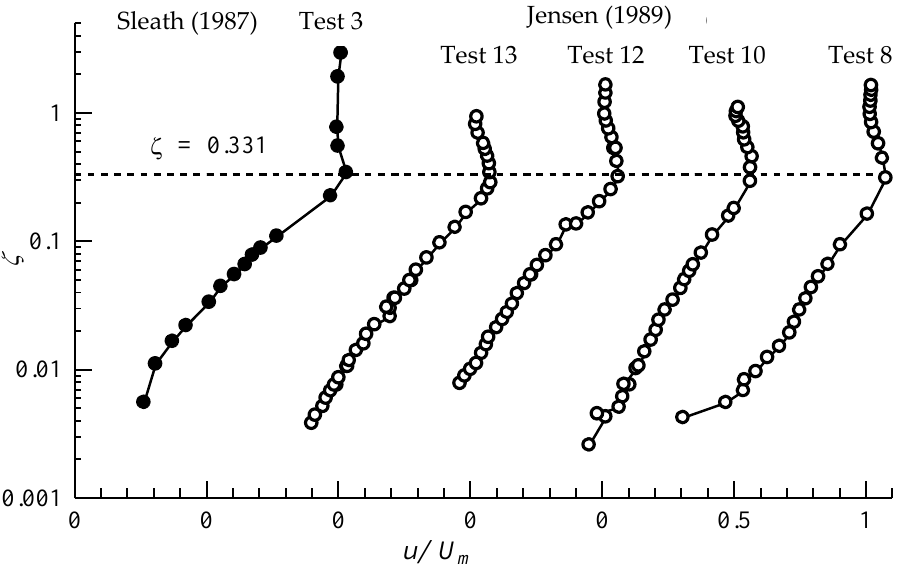
σ t = 0 from laboratory experiments of Sleath [8] and Jensen Figure 5. Velocity profile at 𝜎𝑡 = 0 from laboratory experiments of Sleath [8] and Jensen [30]. Figure 5. Velocity profile at